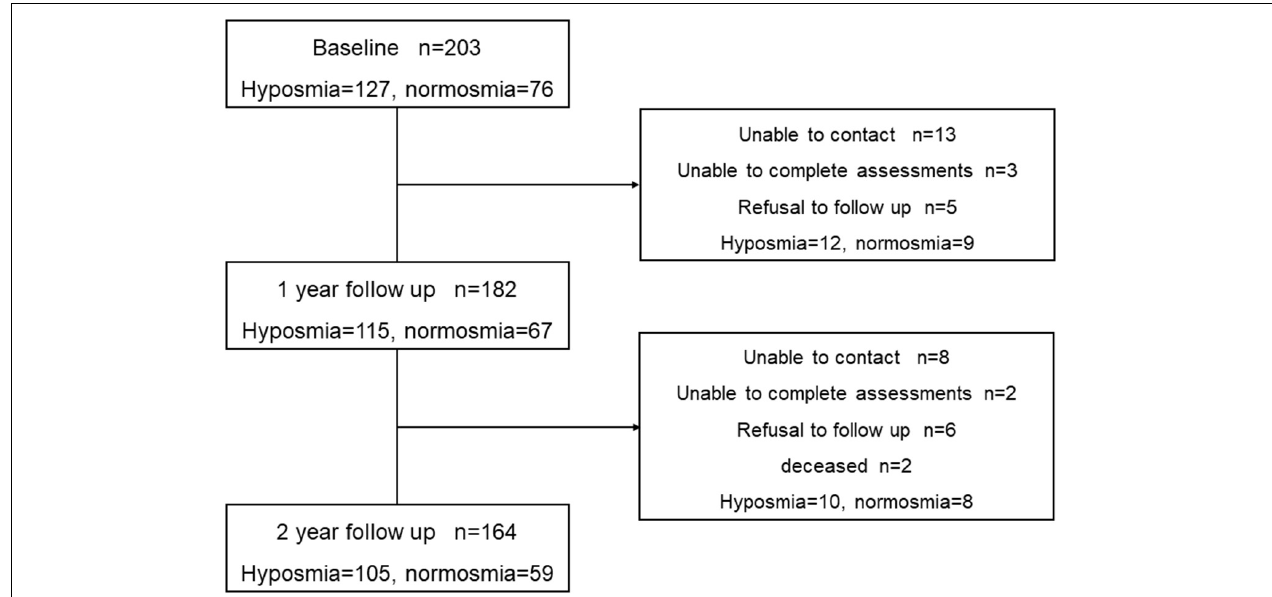
FIGURE 1 | Flow chart of patients with Parkinson’s disease included in the